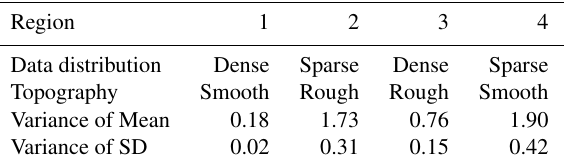
Table 12. Sensitivity of the LSC solutions with respect to their data distribution and topography roughness (mGal 2